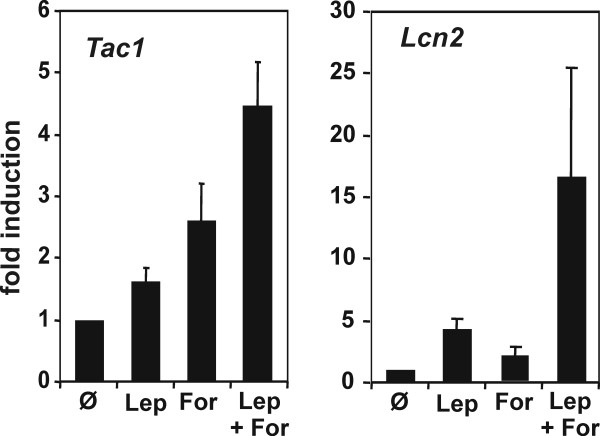
Synergistic regulation of Lcn2 and Tac1 promoter activities by leptin and forskolin in PC-12 pheochromocytoma cells. PC-12 cells stably expressing LEPRb were transiently transfected with the Tac1 or Lcn2 reporter gene constructs. Cells were left untreated or treated with leptin (100 ng/ml) and/or forskolin (10 μg/ml) for 24 hours before lysis. Luciferase activities were determined from duplicate wells and data were normalised to β-galactosidase activities. Data are expressed as fold stimulation by the treatment relative to unstimulated cells. Results are means +/- SD of three (Tac1 promoter) or four (Lcn2-promoter) independent experiments.